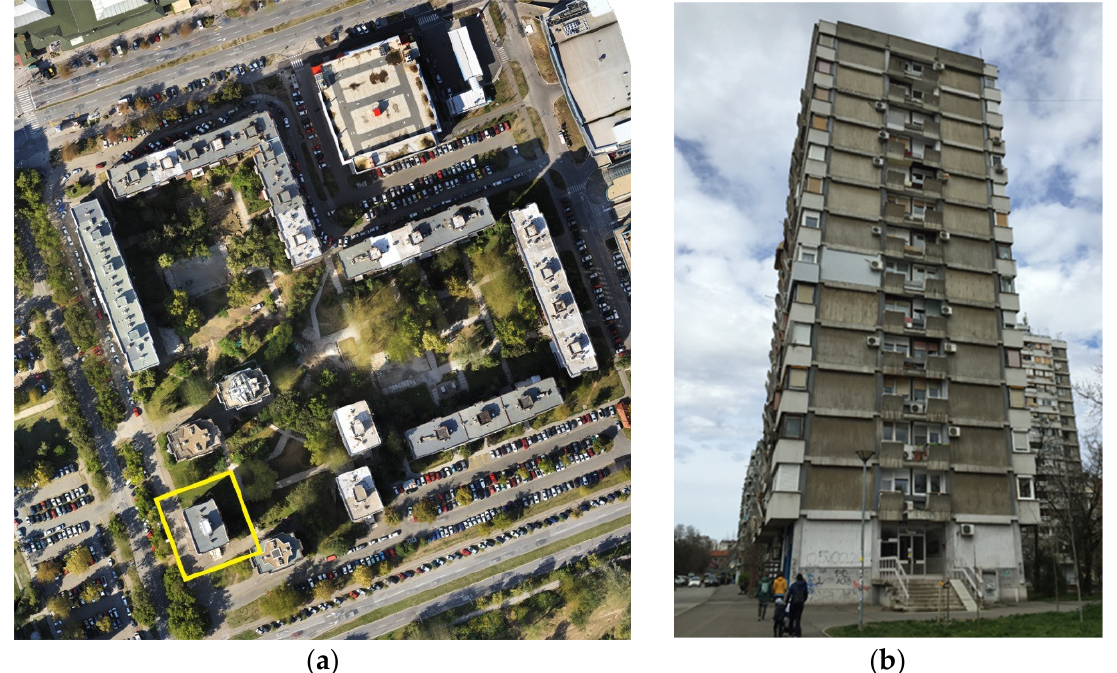
Figure 2. Residential high-rise building in Novi Sad. ( a ) Urban building block built in an industrial way in the second half of XX century with marked case study building; ( b ) high-rise residential building southeast façade.